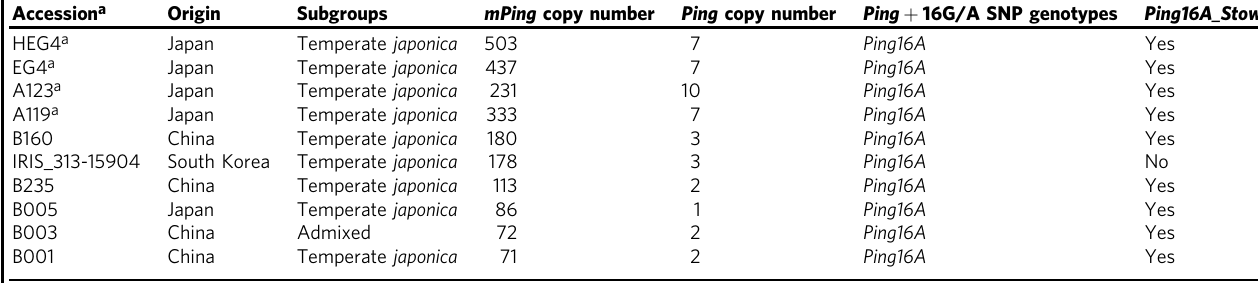
Table 2 Ping copy numbers and genotypes in rice accessions with high copy numbers of